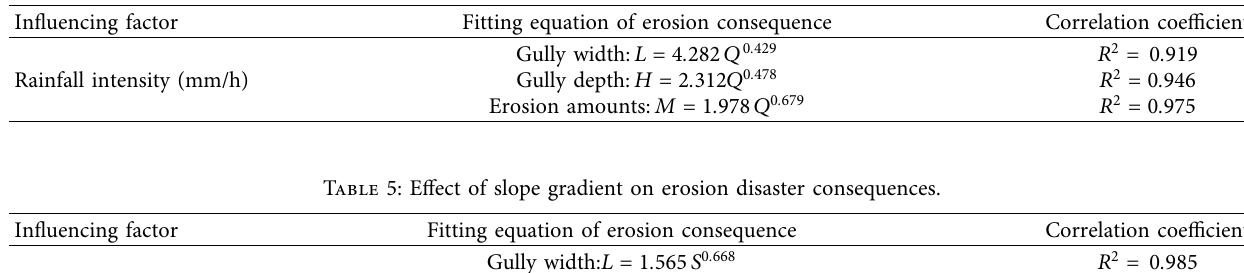
Table 4: Effect of rainfall intensity on erosion disaster consequences.